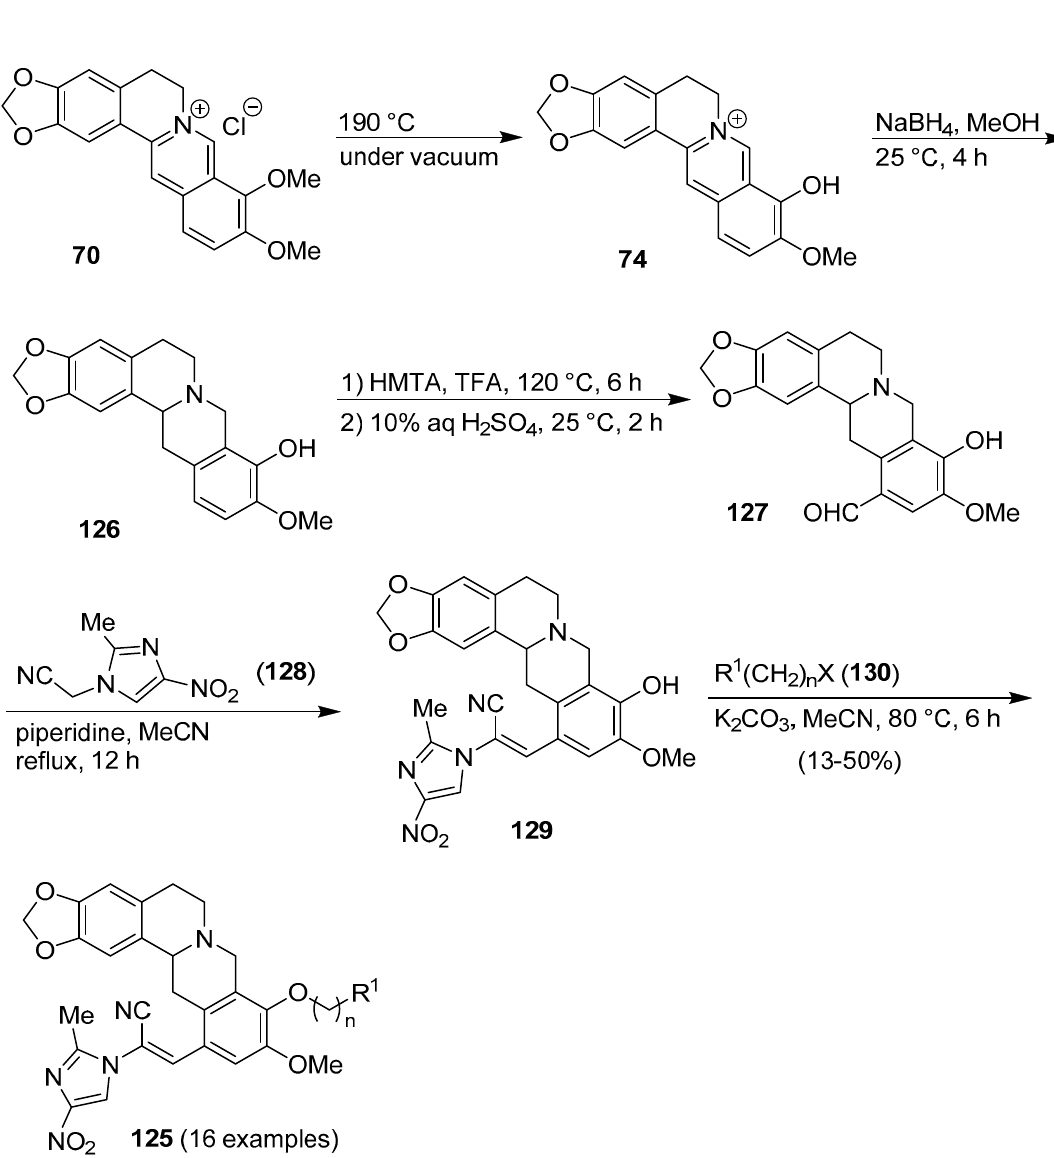
Scheme 23. Synthesis of berberine/nitroimidazole hybrids 125.